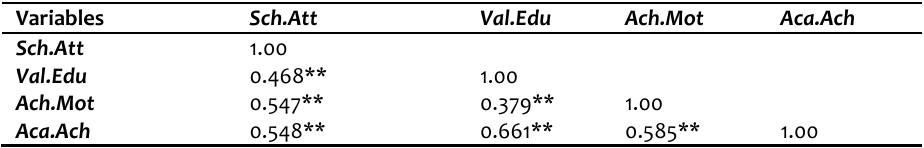
Table ‐ 4: Results of the correlation analysis